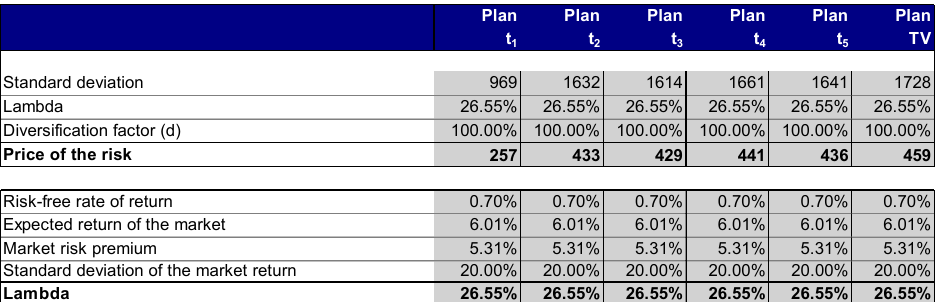
Figure 8. Pricing of the risk.